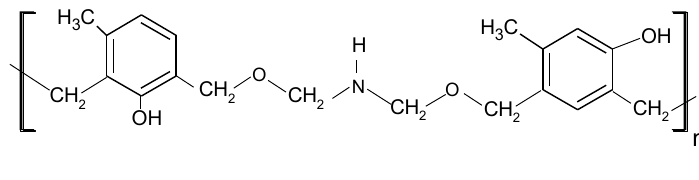
Figure 4: Tentative structure of